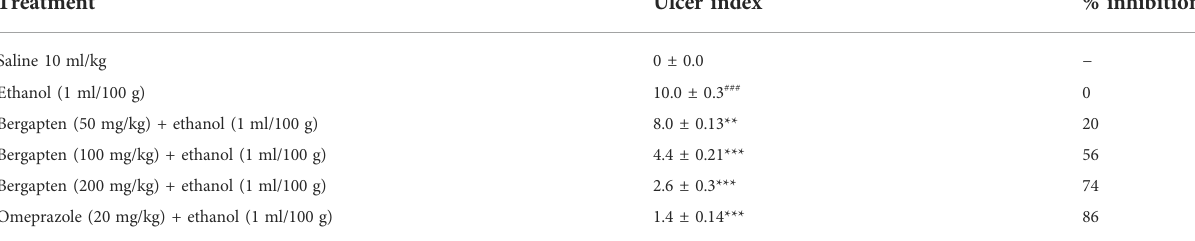
TABLE 3 Protective effect of bergapten and omeprazole against ethanol-induced gastric ulcers in rats.